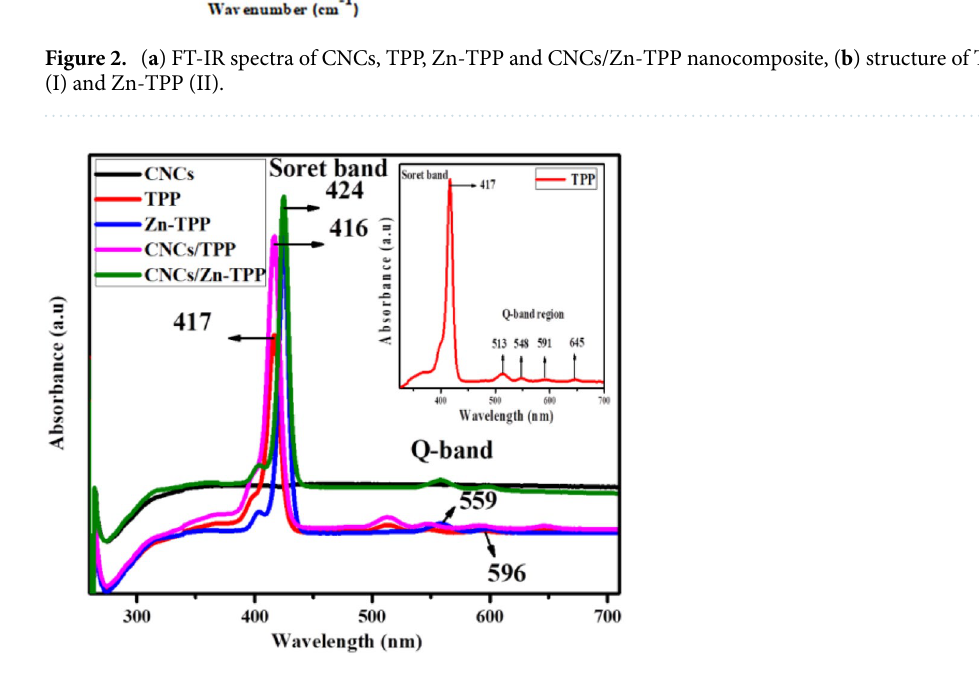
Figure 3. UV/visible spectra of CNCs, TPP, CNCs/TPP, Zn-TPP and CNCs/Zn-TPP in